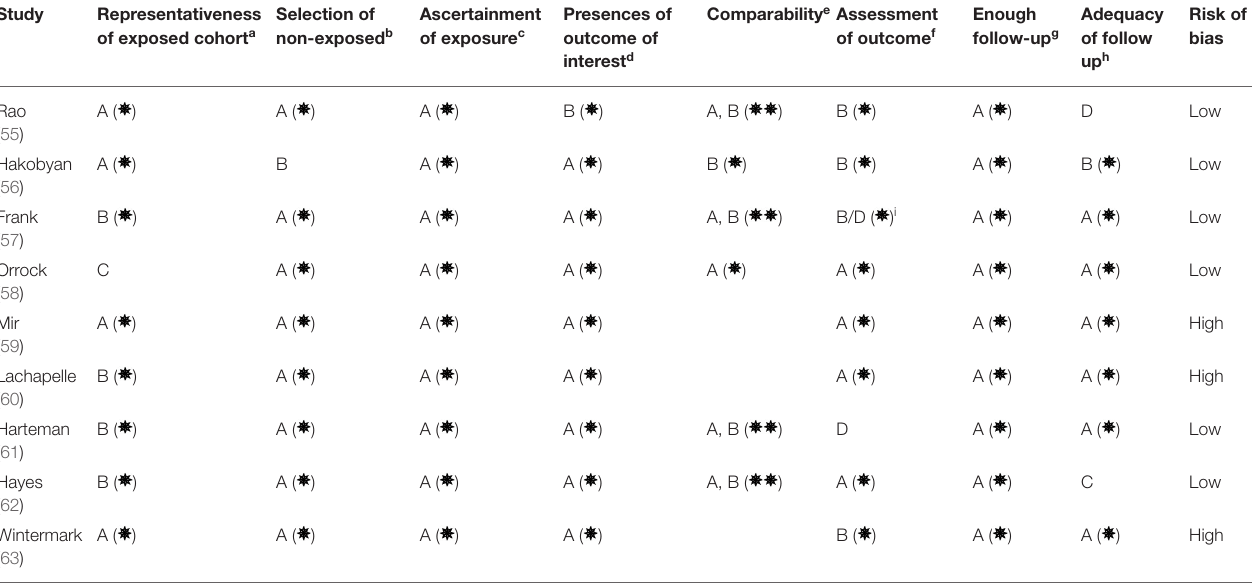
TABLE 5 | Points awarded by the Newcastle-Ottawa Scale to the included studies investigating the association between newborn encephalopathy, perinatal infection, and neurological outcome. Study Representativeness Selection of of exposed cohort a non-exposed